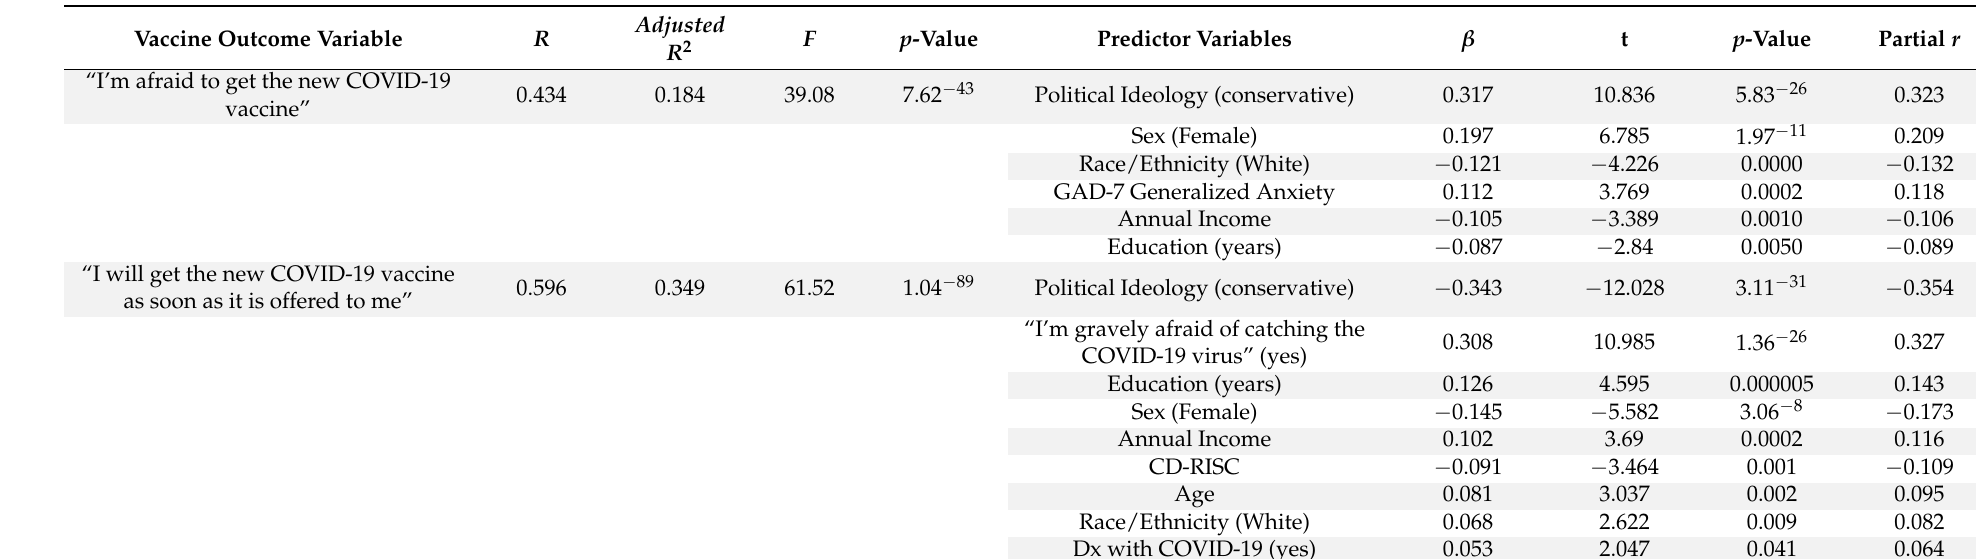
Table 3. Results of Stepwise Multiple Linear Regression for Each Vaccine